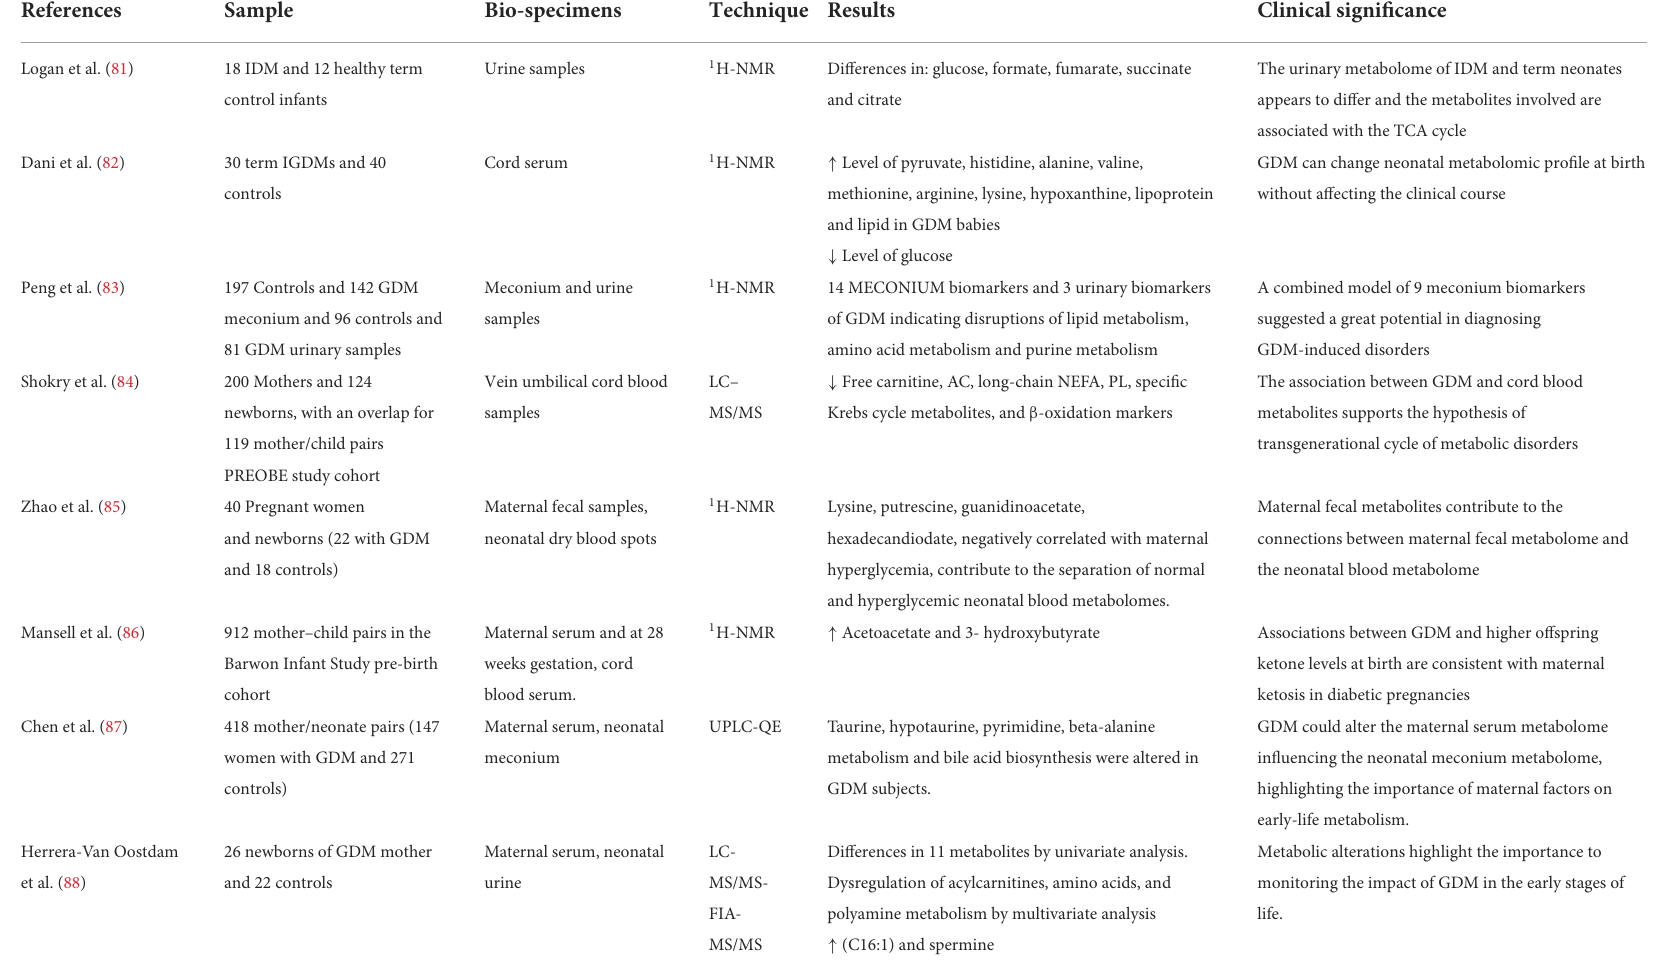
TABLE 2 Metabolomic studies of infants born to women with and without